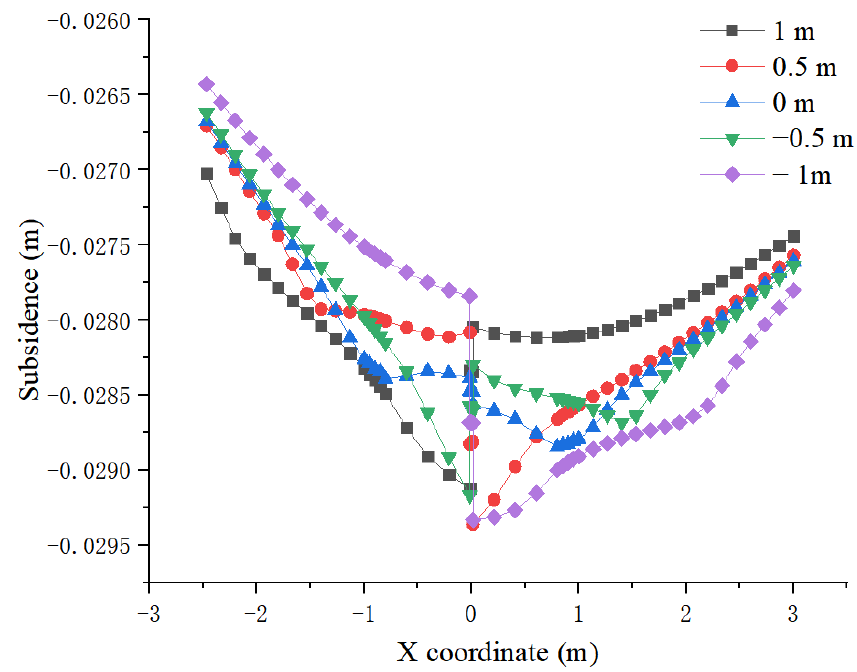
Figure 23. Distribution of dam subsidence at 14.625 m under different load positions.